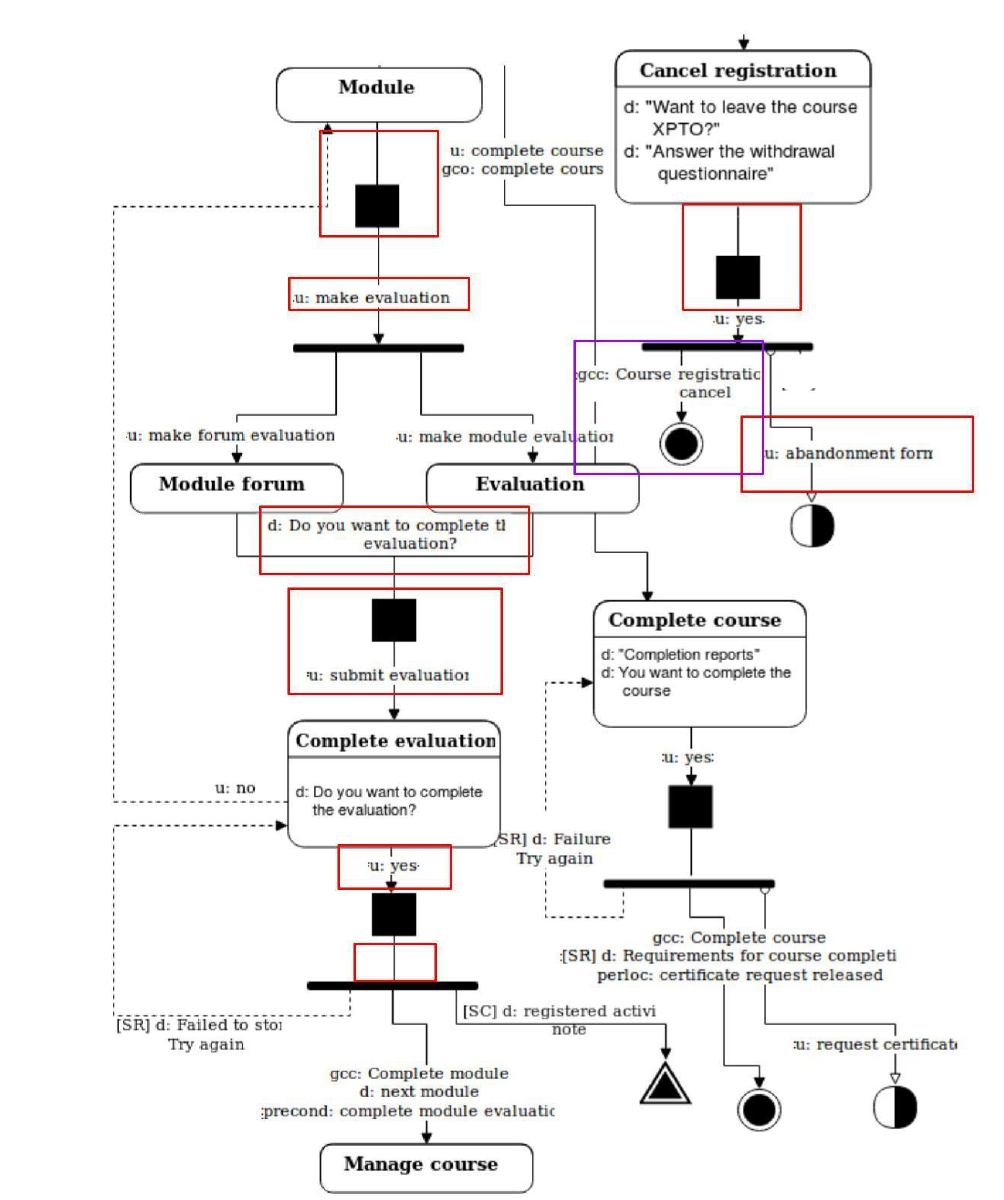
Figure 7. Diagram course. Highlighted in Figure 8 in purple color are two closing direction represented in the diagram, which should not elements of the final goal conversation. The elements were happen in the representation of this represented wrongly, as the two arrows are with the